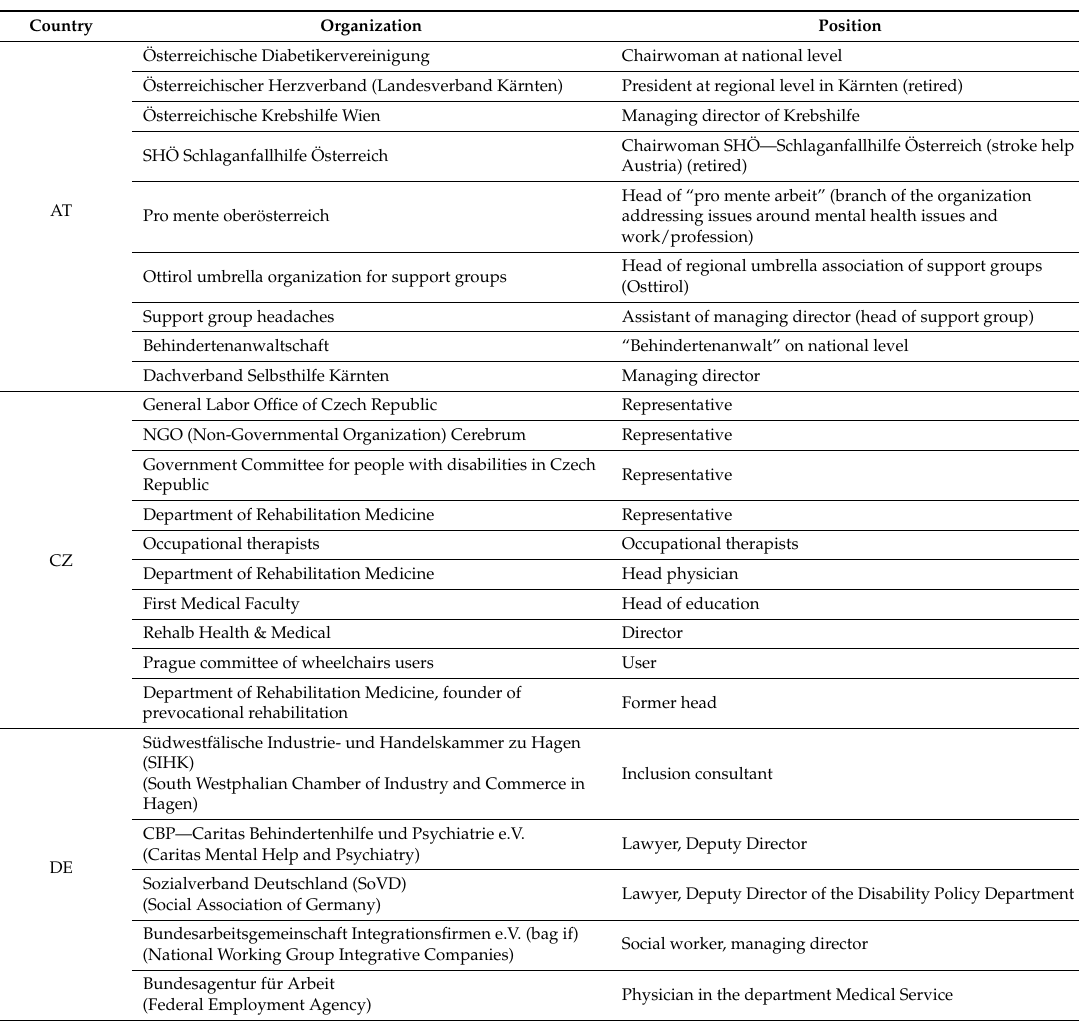
Table A1. Questionnaire